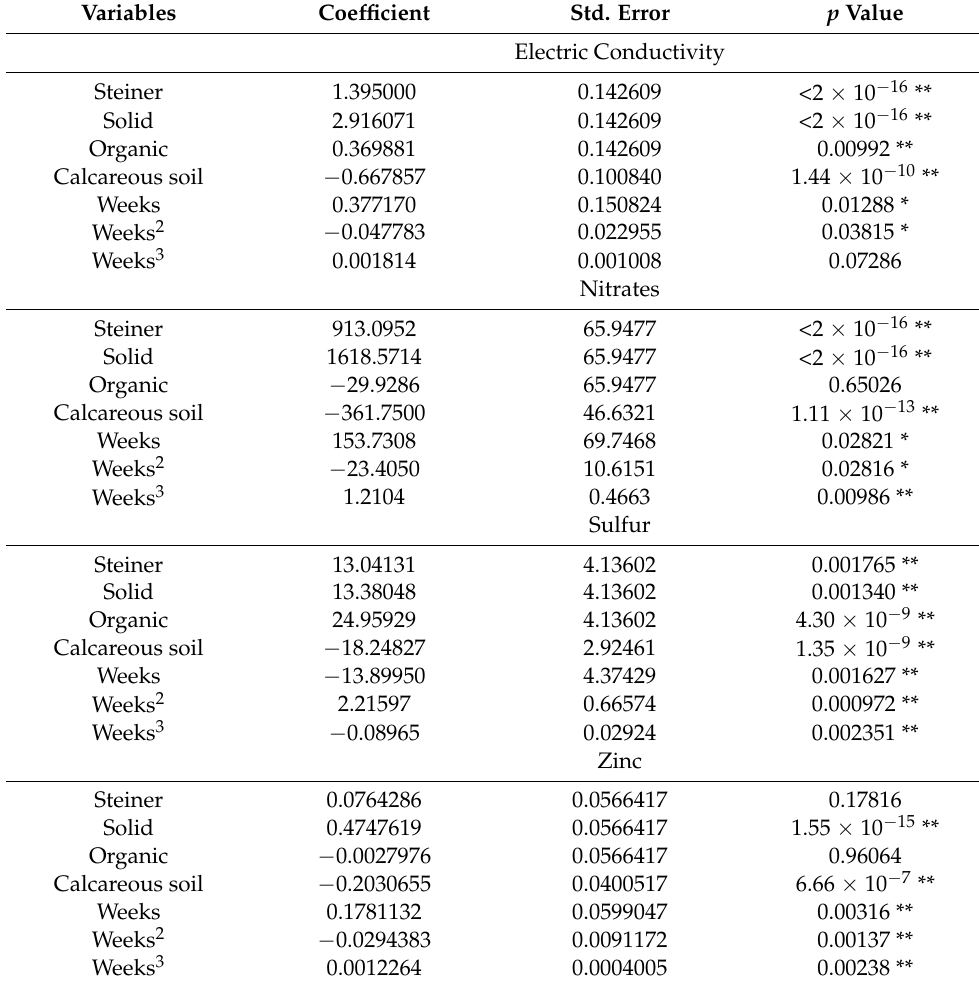
Table 8. Multiple polynomial model between electrical conductivity, nitrates, sulfur, zinc, and three variables: two explanatory variables (treatment and soil type) and one numerical variable (weeks) of cubic degree. The reference treatment for the comparison of the different nutrient contribution scenarios was irrigation water, while the forest soil was used as a reference to compare it against the calcareous